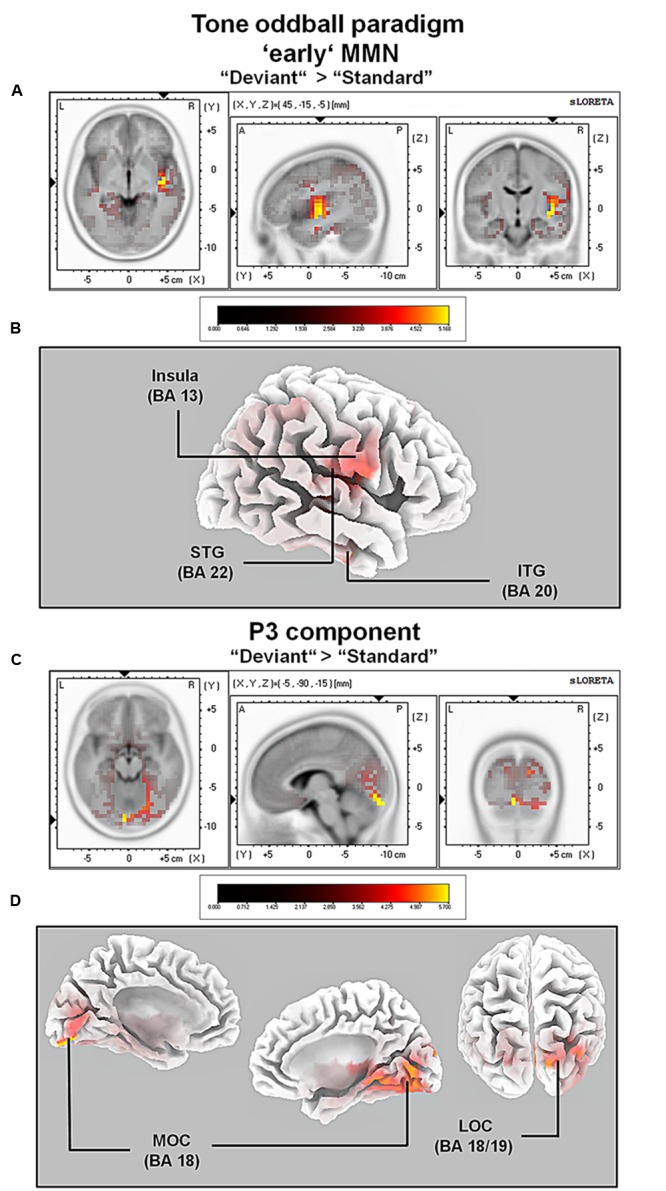
Results of the standardized low-resolution brain electrotomography (sLORETA) source localization analysis (contrast: “Deviant” > Standard”) in the averaged time window of the ‘early’ MMN and P3 components (84–129 and 242–344 ms, respectively). Images have been obtained after statistical non-parametric mapping (SnPM) and co-registration to the stereotaxic Talairach space based on the Co-Planar Stereotaxic Atlas of the Human Brain (Talairach and Tournoux, 1988) and the probabilistic MNI-152 template (Mazziotta et al., 2001). Activated voxels are indicated by yellowish and reddish colors [after correction for multiple comparisons (p < 0.01 and p < 0.05, respectively)]. (A) The peak of highest cortical activity has been found in parts of the superior temporal gyrus (STG; BA 22). (B) A shifted lateral view of the right hemisphere, showing cortical activations on the three-dimensionally rendered Colin27 template (Holmes et al., 1998). (C) The peak of highest cortical activity was found in the left medial occipital cortex (MOC; BA 19). (D) Two medial views on the left as well as the right hemisphere with cortical activations in the medial occipital cortices bilaterally and additionally in the right lateral occipital cortex (LOC; BAs 18 and 19), rendered on the Colin27 template (Holmes et al., 1998). L, left; R, right; A, anterior; P, posterior; MNI, Montreal Neurological Institute; X, Y, Z, corresponding MNI coordinates; BA, Brodmann area; MOC, medial occipital cortex; LOC, lateral occipital cortex; PCC, posterior cingulate cortex; ITG, inferior temporal gyrus.